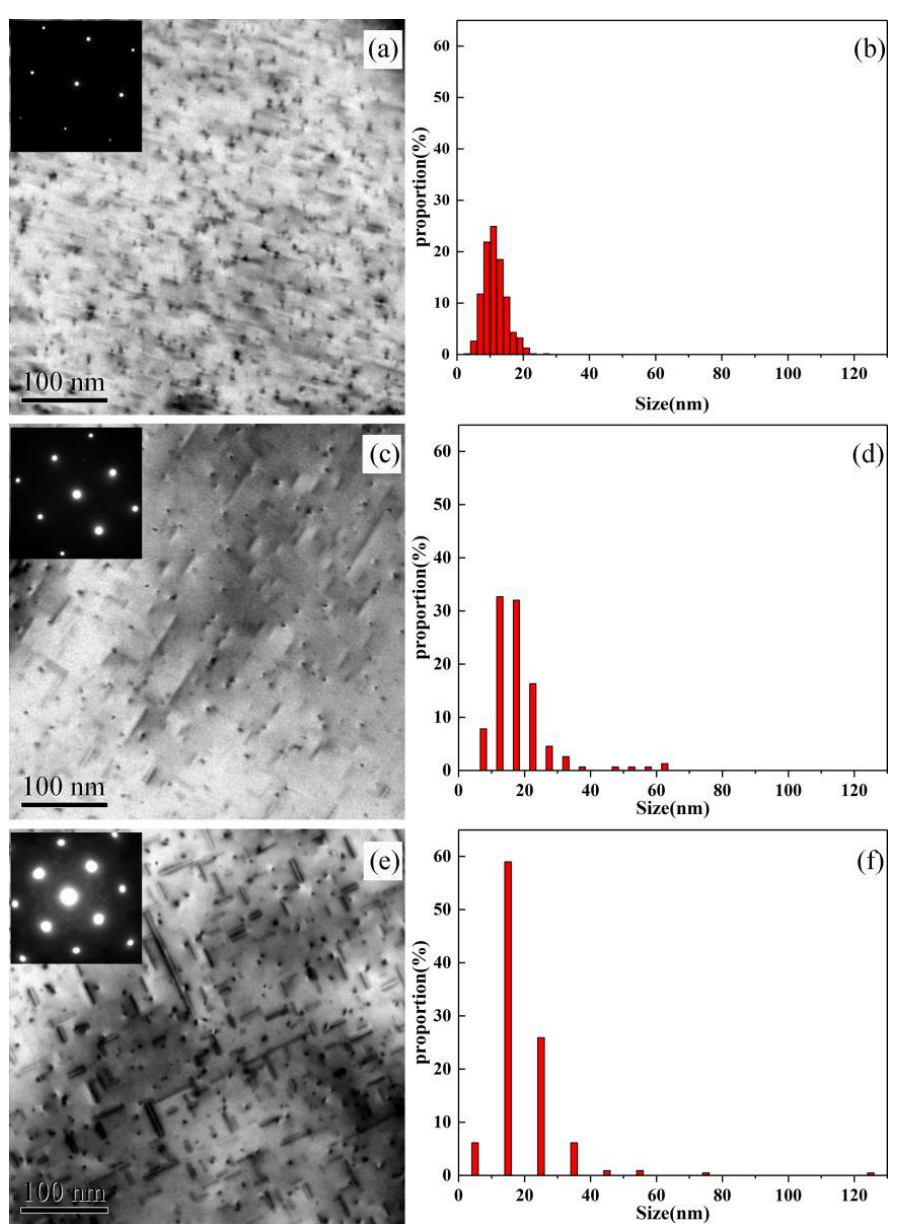
Figure 2. Transmission electron microscope (TEM) on intragranular precipitates of alloy AA and the size distribution of needle phase under 170 °C aging ( a , b ) under aged state, ( c , d ) peak aged state, and ( e , f ) over aged state.